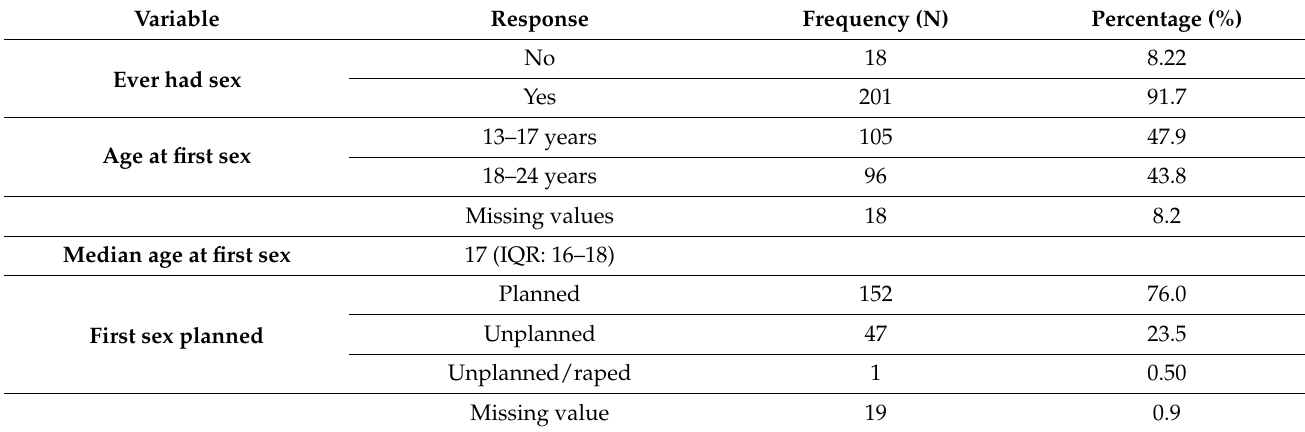
Table 2. Sexual behavior (n = 219) of